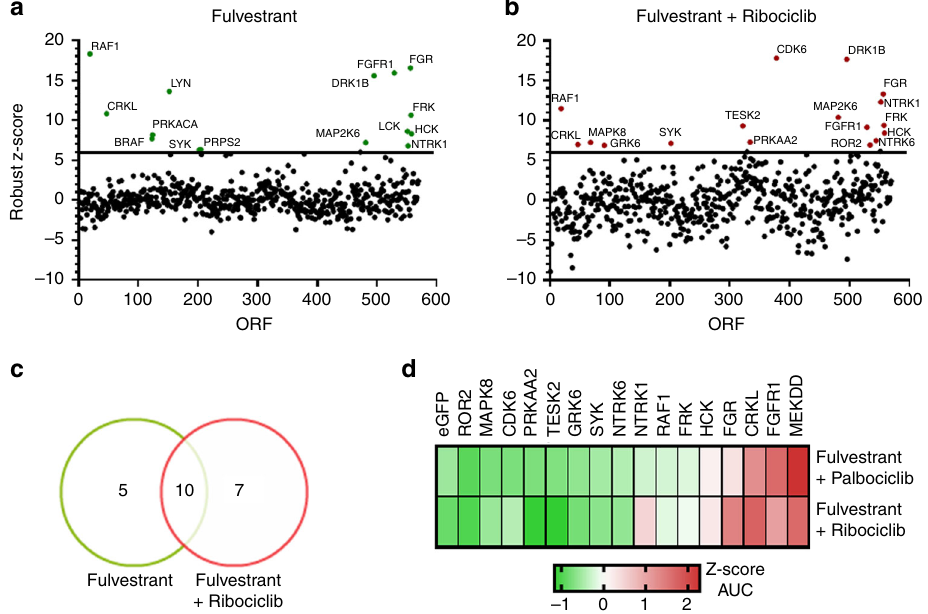
Fig. 1 ORF kinome screen identi fi es drivers of resistance to fulvestrant ± CDK4/6 inhibitors. a , b ORF kinome screen in MCF-7 cells treated with fulvestrant ( a ) or fulvestrant plus ribociclib ( b ). ORFs are visualized by plotting the function y = z -score, x = gene name. Data points represent the average of two replicate plates. c Modi fi ed Venn diagram of screening results showing the number of fulvestrant hits (left) or fulvestrant plus ribociclib hits (right). d Heat map displaying validation results of the hits selected in the fulvestrant plus ribociclib screen. Top and bottom row show the normalized area under the curve (AUC) for each candidate genes with 5-point drug concentration, fulvestrant plus palbociclib (top row) and fulvestrant plus ribociclib (bottom row). GFP and mutant MEK S218/222D (MEK-DD) were used as internal